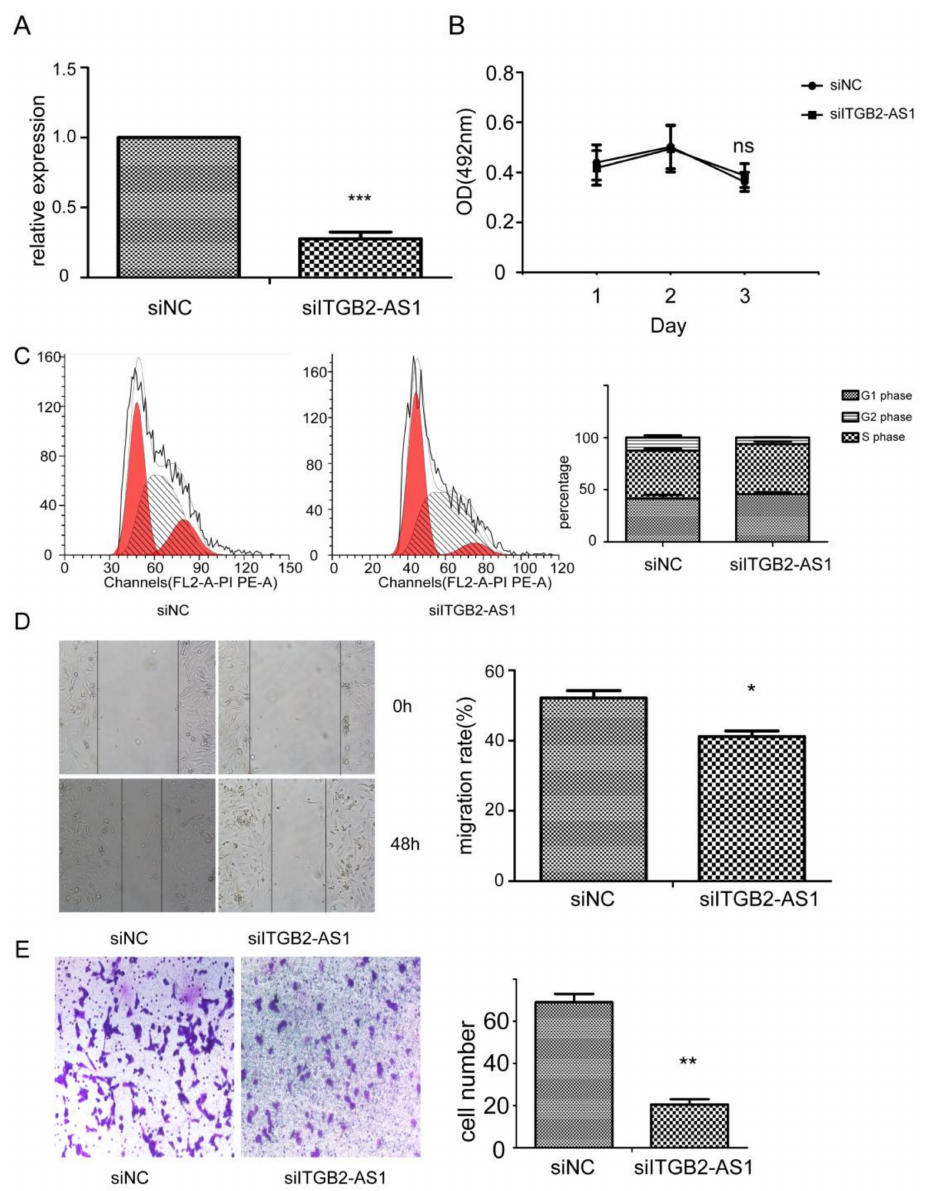
Figure 3. Knock-down of ITGB2-AS1 will exert inhibitory effect on migration and invasion of breast cancer cell. ( A ) The efficacy of siRNA fragment was verified by quantitative PCR; ( B ) The cell viability was detected by MTT assay; ( C ) The cell cycle distribution was measured by flow cytometry. Left panel: X-axis: cell number; Y-axis: DNA content; ( D ) The migration was evaluated by wound healing assay; ( E ) The invasion was detected by transwell chamber assay. Stained with 0.1% crystal violet (400 × ). Data are shown as mean ± SD. * p < 0.05, ** p < 0.01, *** p < 0.001 vs. control